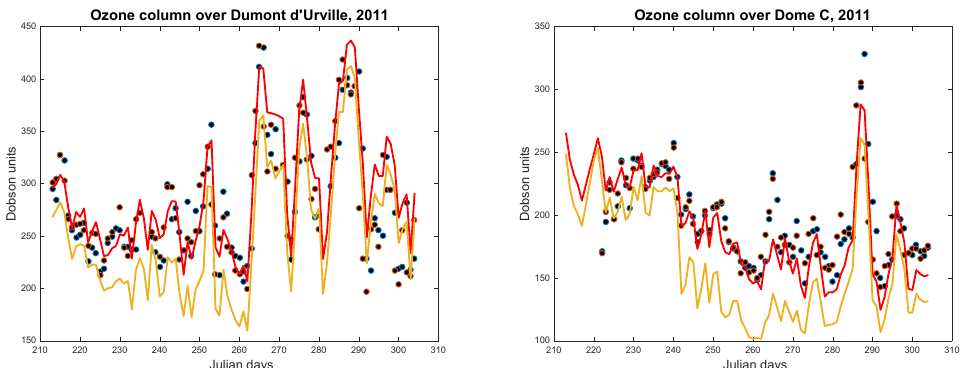
Figure 8. Evolution of the total ozone column over the Dumont d’Urville and Dome C Antarctic stations. The dots are the observations of the SAOZ instrument, the orange line is the evolution calculated in the reference simulation, MR, and the red line the same output from the simulation MA using the ASIS